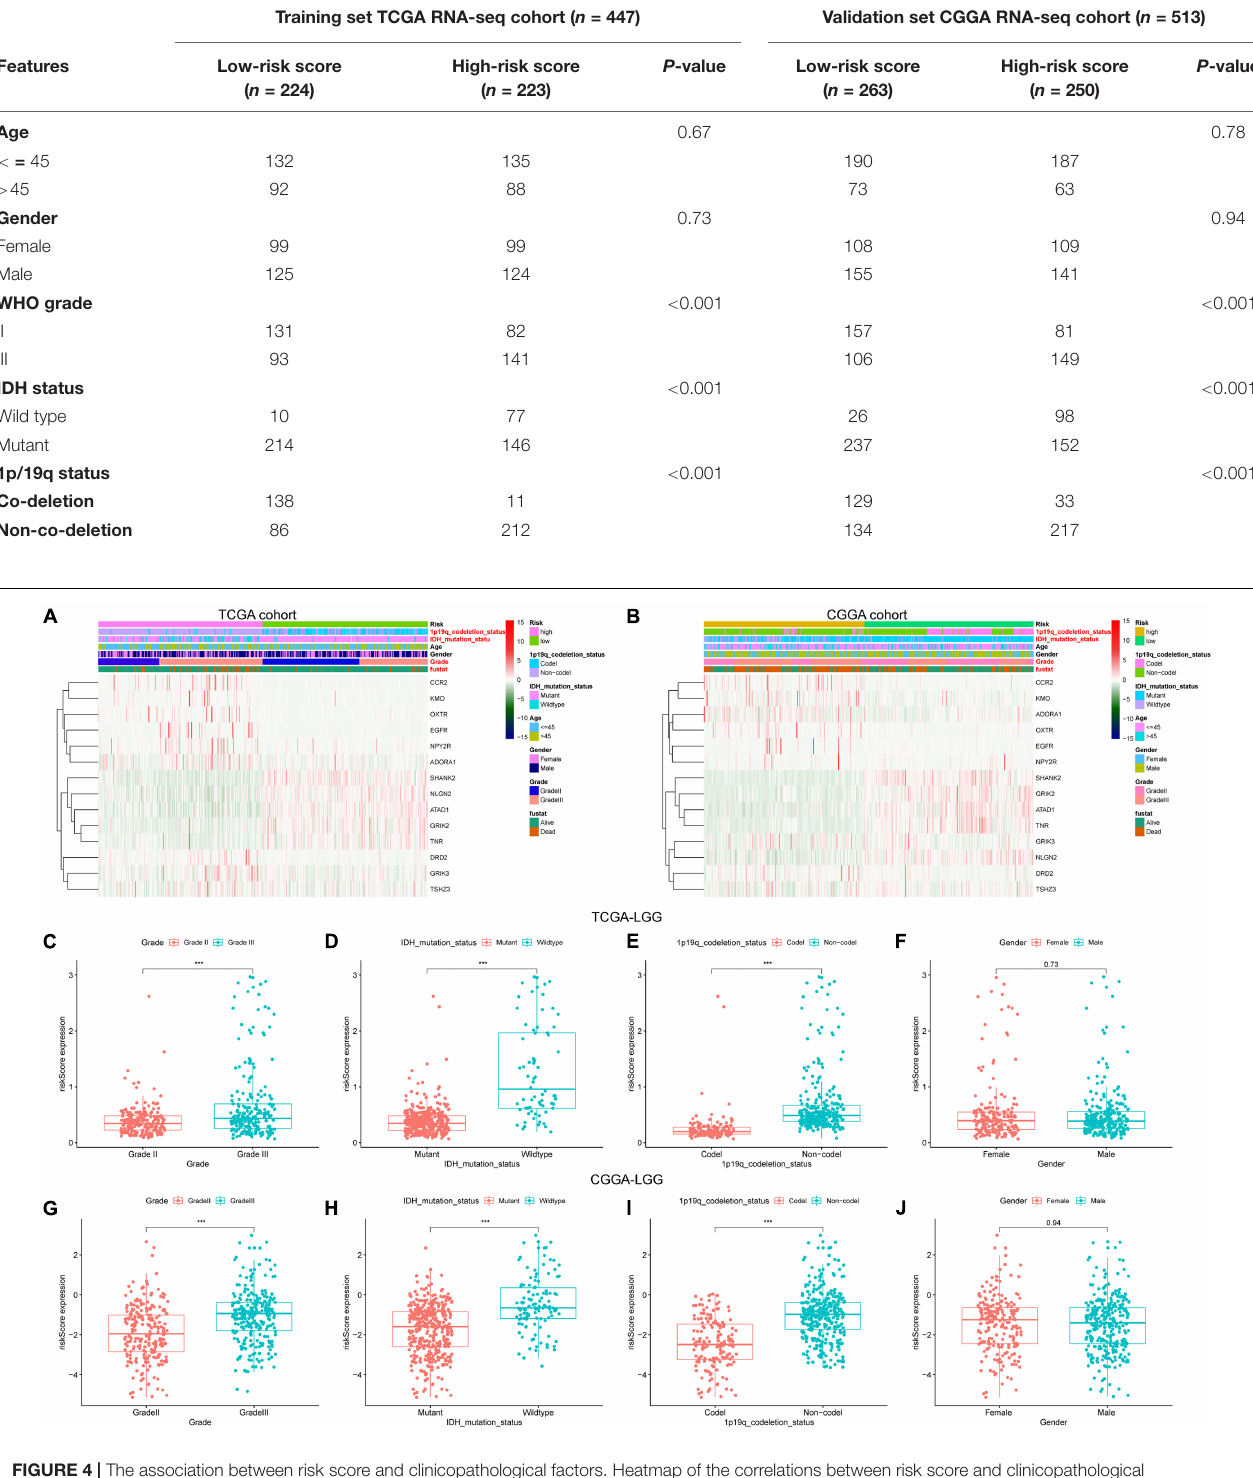
Frontiers in Molecular Neuroscience |